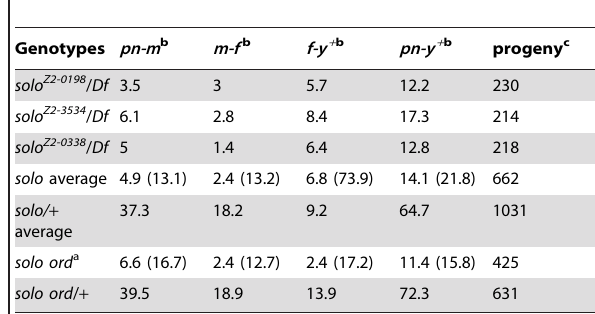
Table 2. Sister chromatid versus homolog NDJ for chromosome 2 in solo females.